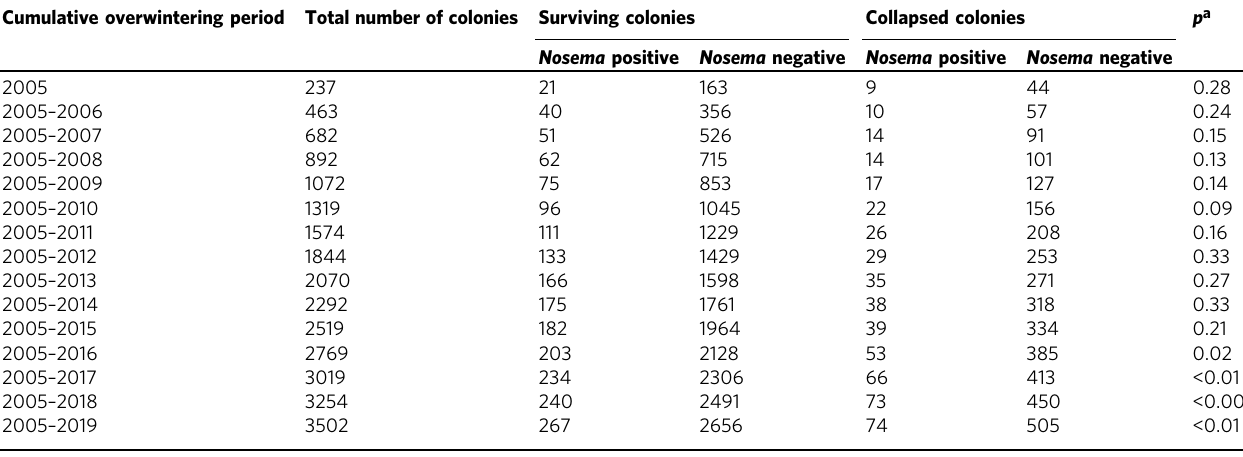
Table 2 Cumulative data subsets for determining the effects of Nosema spp.-infection in the autumn on honey bee colony losses in the following